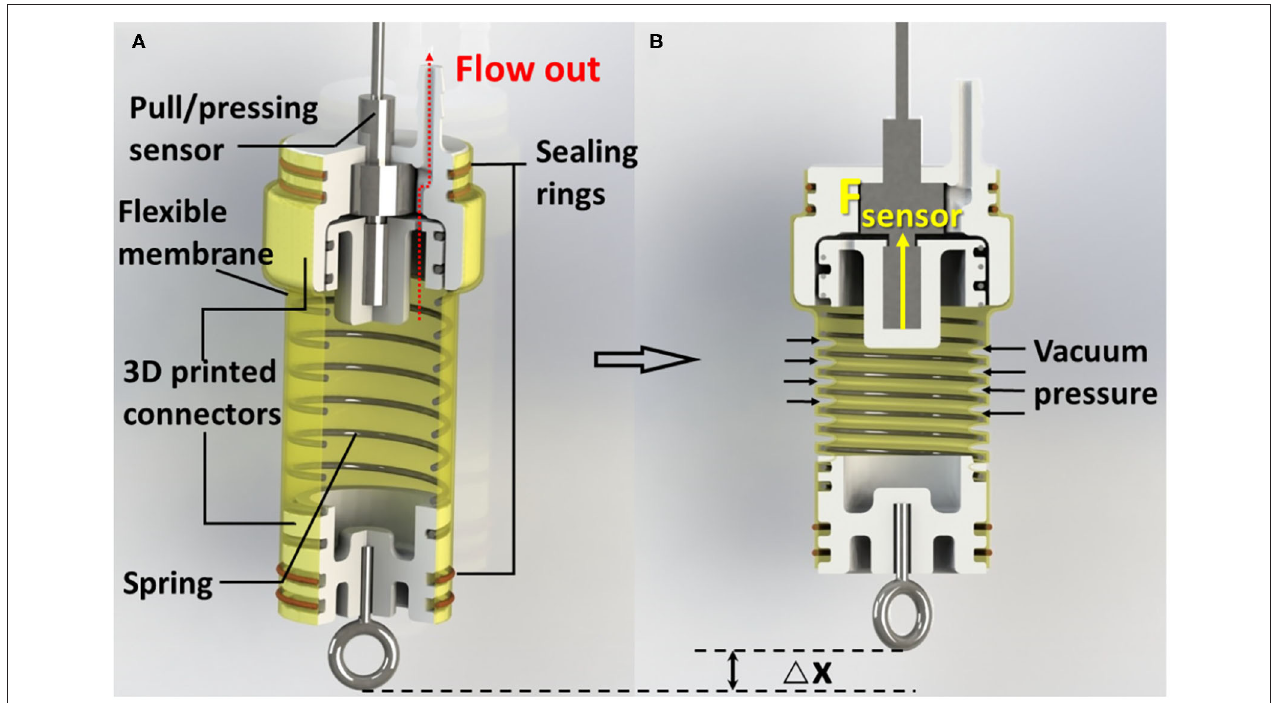
FIGURE 1 | (A) Cutaway view of the Self-sensing Pneumatic Compressing Artificial Muscle (SPCAM). A typical SPCAM mainly consists of a compressing spring, 3D-printed parts, a flexible membrane, seals, and a pull/pressing sensor. (B) SPCAM under working state. The vacuum pressure pushes the membrane deform inward to make the actuator contract.